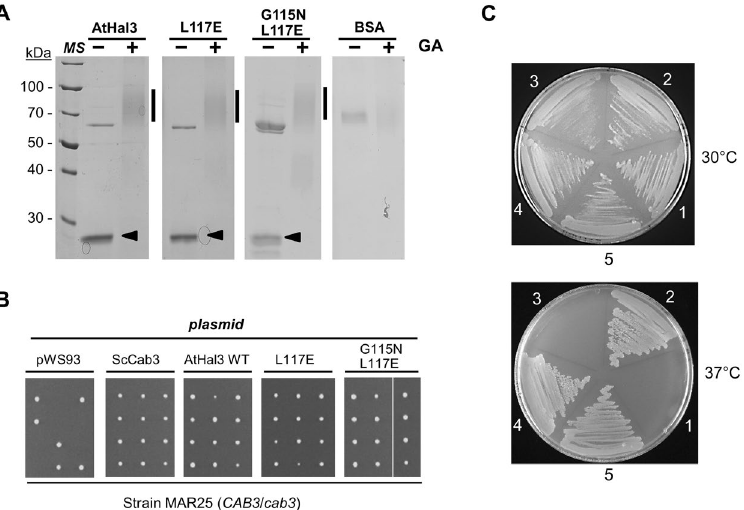
Figure 3. In vitro trimerization ability and in vivo PPCDC function of AtHal3 variants. ( A ) In vitro crosslinking of AtHal3 variants. Samples (1 μ g) of native AtHal3a or its variants were incubated with 0.01% glutaraldehyde (GA, + ) or treated with vehicle alone ( − ). Samples were resolved by SDS-PAGE (10% polyacrylamide gel) and proteins were visualized by staining with Coomassie Brilliant Blue R-250. The arrowhead denotes mobility of the untreated monomer and the vertical bar on the right indicates the region at ∼ 70–80 kDa (the expected size of a homotrimer). Note the presence of a ∼ 70 kDa contaminating protein of bacterial origin (DnaK). Original images can be found in Supplementary Fig. S3. ( B ) The indicated proteins were expressed from the pWS93 vector in strain MAR25, a diploid heterozygous for the cab3 deletion (which is lethal in homozygosity). Upon sporulation, tetrads were dissected. Growth of all four spores indicates that the specific protein can replace in vivo Cab3 and, thus, likely conserve PPCDC function. ( C ) E . coli strain BW369 ( dfp-707 ts) was transformed with the empty plasmid pGEX6P-1 (1), or the same plasmid carrying native AtHal3 (as positive reference, 2), native ScHal3 (negative control, 3), AtHal3 L117E (4), and AtHal3 G115N L117E (5) and streaked on ampicillin- containing plates. Plates were incubated at 30 °C (permissive) or 37 °C (restrictive temperature) for 24 h.